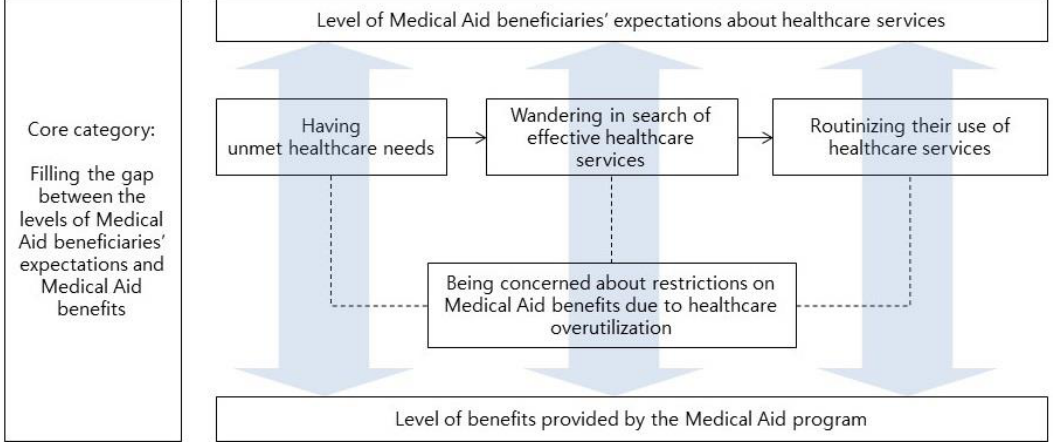
Figure 1. The healthcare seeking process of Medical Aid beneficiaries.